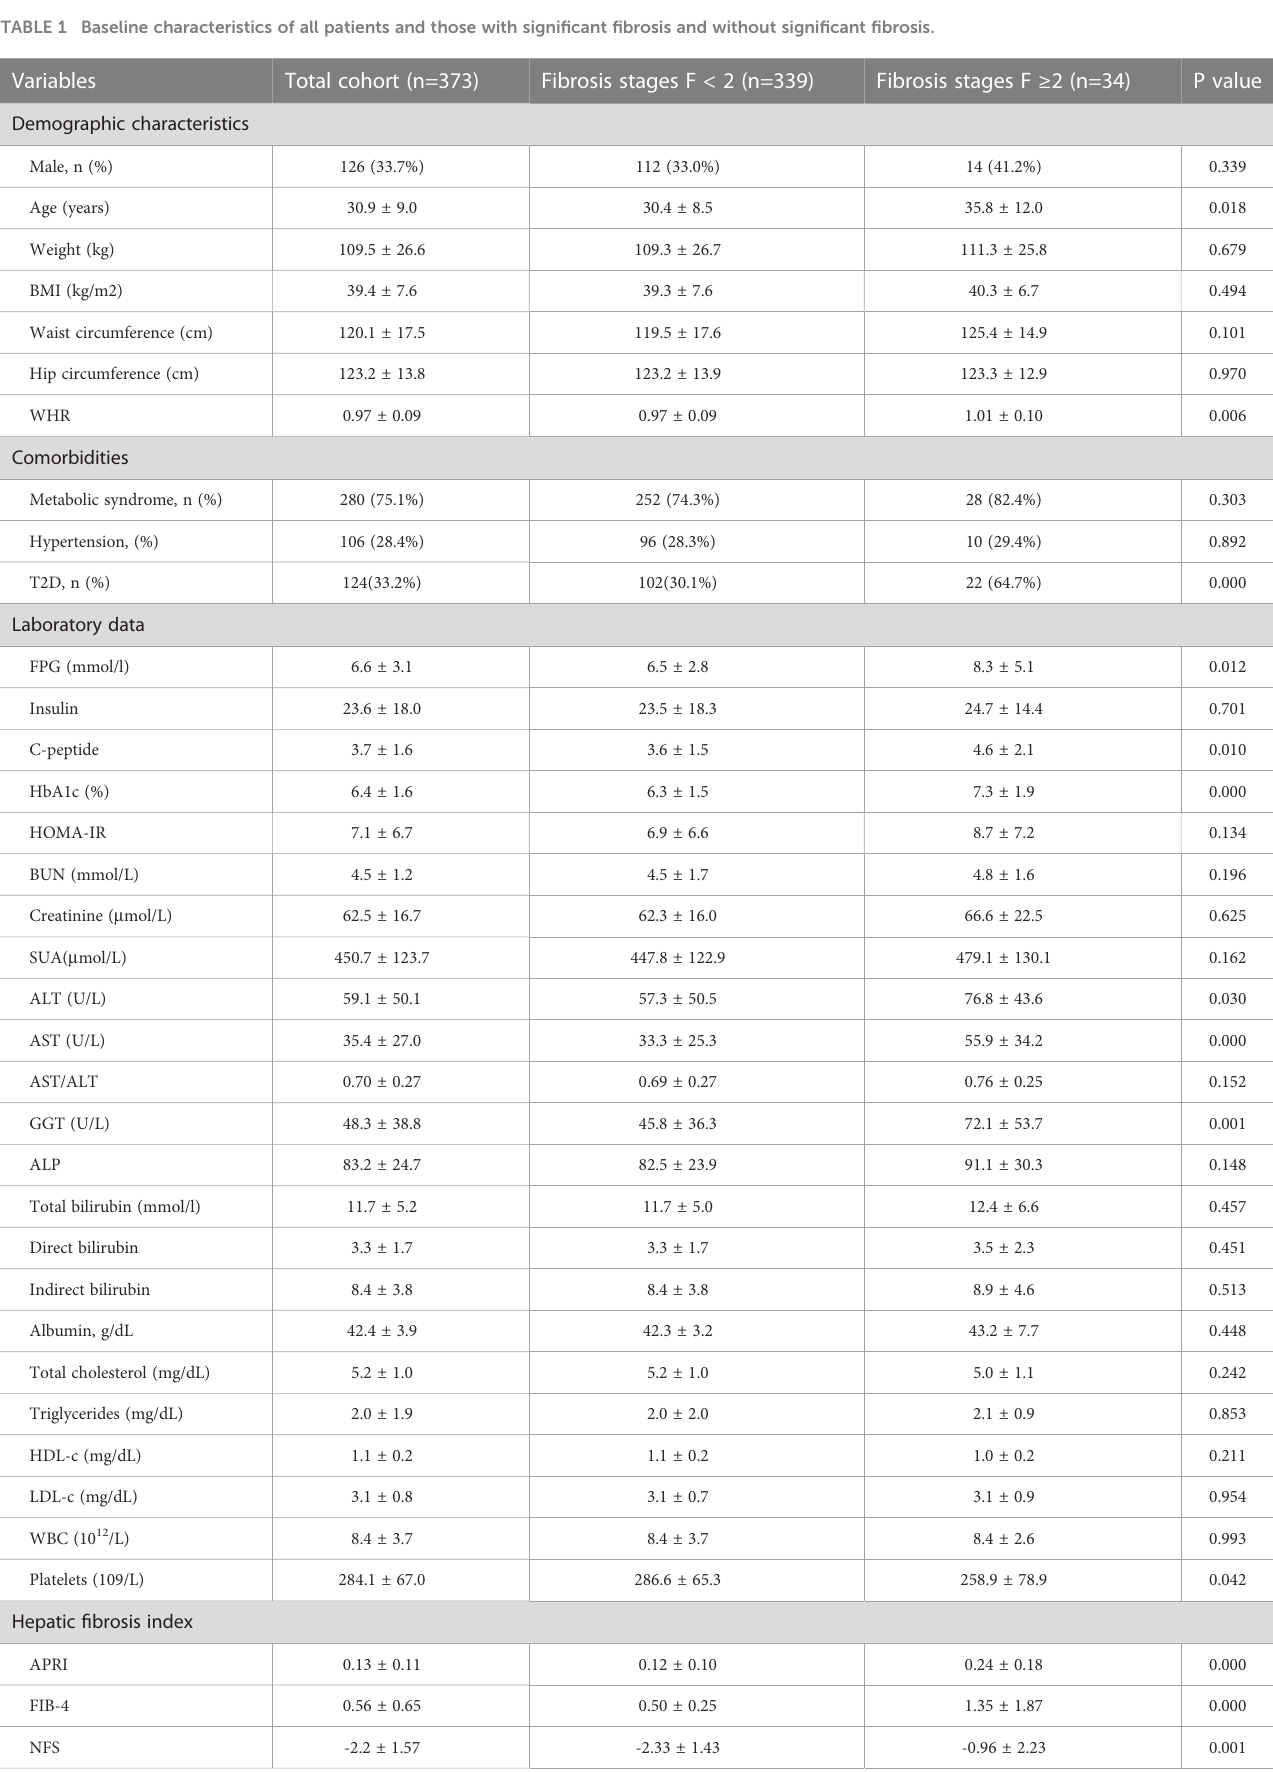
TABLE 1 Baseline characteristics of all patients and those with signi fi cant fi brosis and without signi fi cant fi